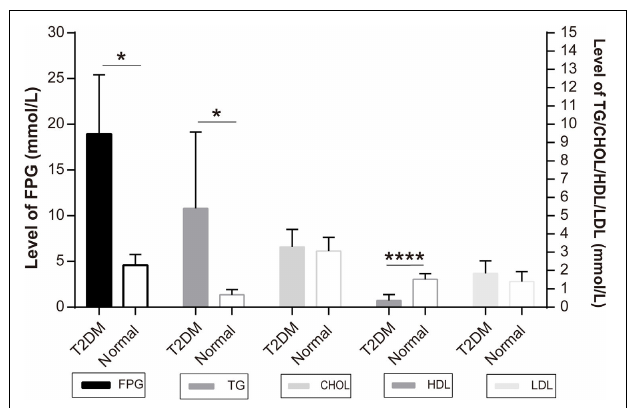
FIGURE 1 | Independent samples test of diabetic and normal monkeys’ biochemical indicators: the Y -axis of FPG level is on the left and the Y -axis of TG, CHOL, HDL, LDL is on the right: * p < 0.05, **** p < 0.0001.